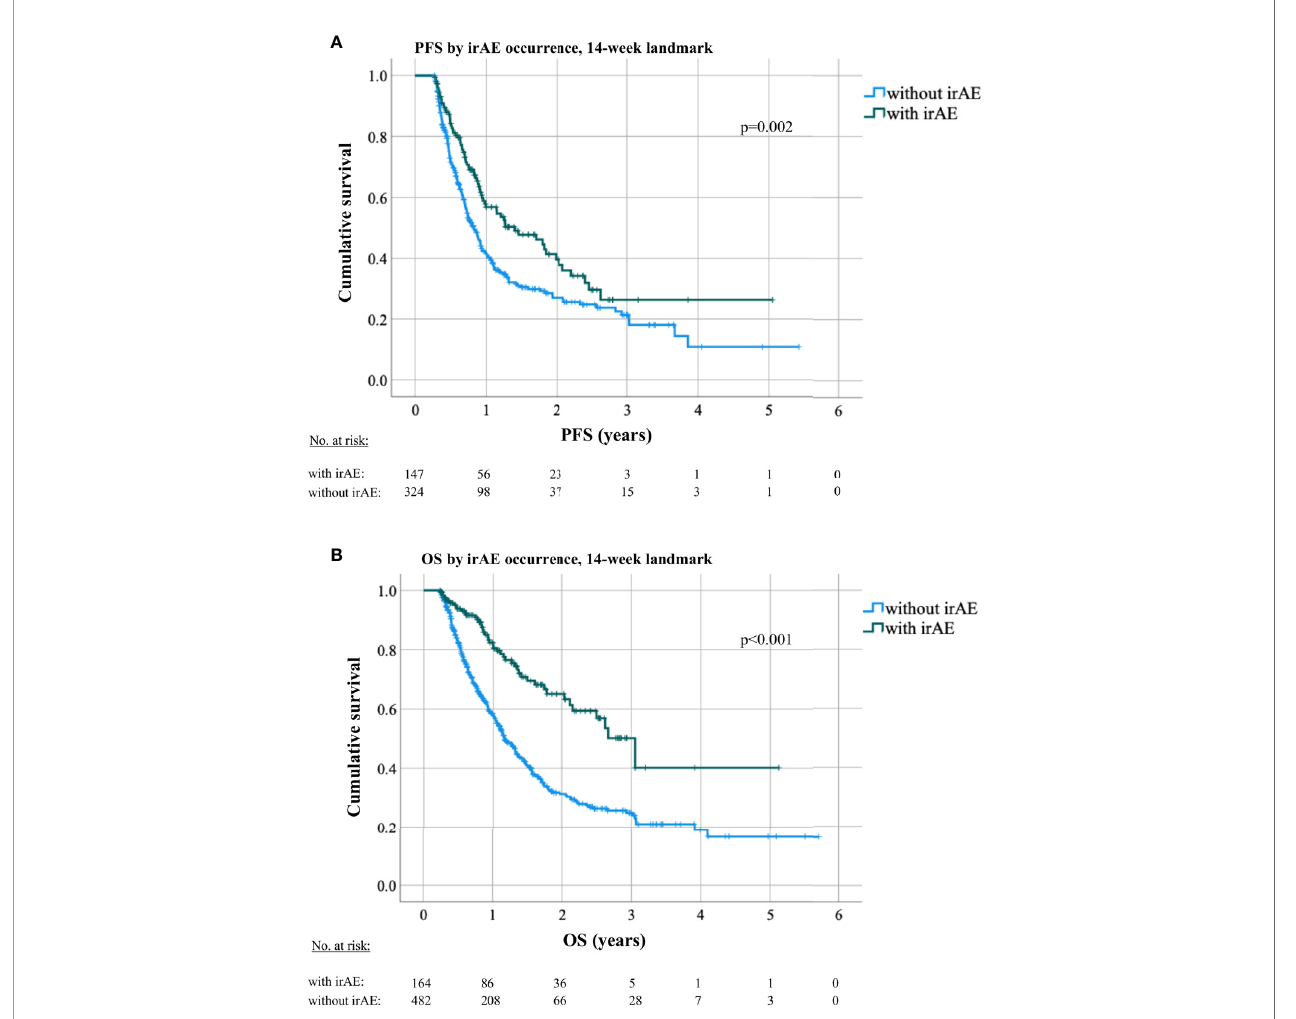
FIGURE 4 | Progression-free and overall survival by occurrence of irAEs in a 14-week landmark analysis. (A) The median PFS under immunotherapy was 10 months (8.7 – 11.4) for patients without irAE vs. 17 months (10.3 – 23.6, logrank p = 0.003) for patients with irAEs in a 14-week landmark analysis. (B) The median OS was 15 months (13.5 – 16.6) for patients without irAE vs. 37 months (28.7 – 44.6, logrank p < 0.001) for patients with irAE in a 14-week landmark